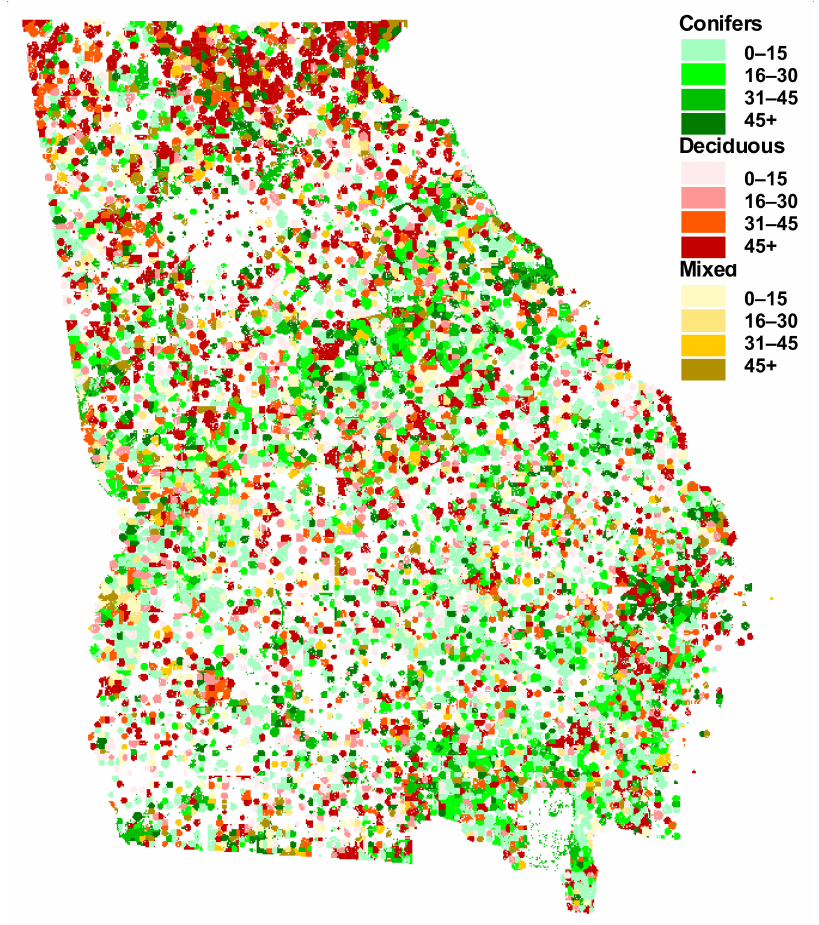
Figure 5. Age distribution by forest type in